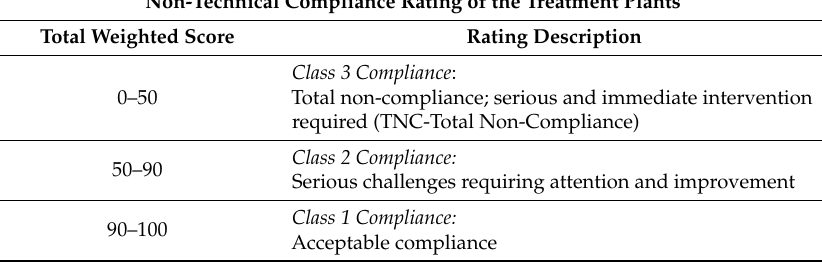
Table 3. Non-technical compliance rating of the treatment plants